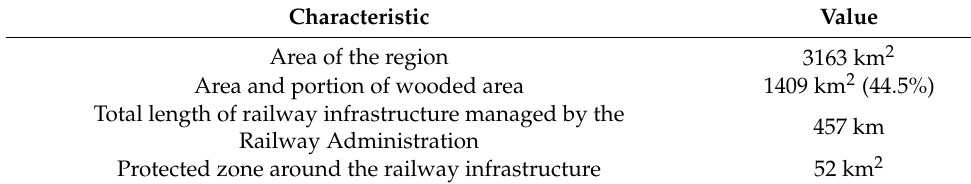
Figure 7. Location of the Liberec Region in the Czech Republic. Table 1. Characteristics of the Liberec Region [39,42].